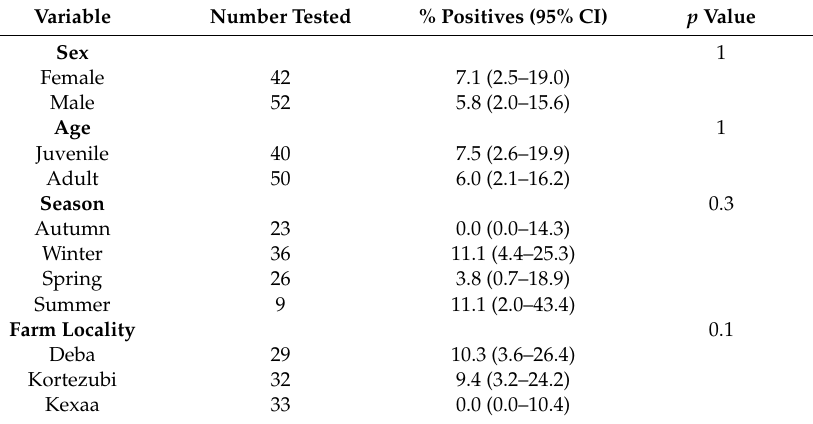
Table 3. Prevalence of non-tuberculous mycobacteria (NTM) detected in A. sylvaticus according to the categorical